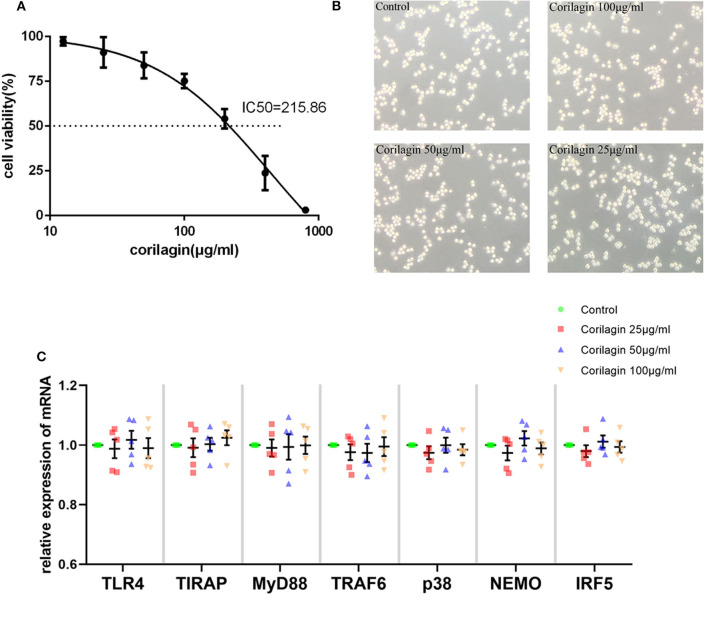
Cytotoxicity of Corilagin (A) CCK8 assay of Ana-1 cell viability. The concentration–effect curve was Y = (152.95/(1+10logX−2.635)−51.95. IC50 = 215.86 μg/ml. (B) Morphology of Ana-1 cells after corilagin treatment for 24 h. (C) mRNA expression measured by qRT-PCR. Data are the mean and SEM. No significant difference was found between groups determined by one-way ANOVA and subsequent S–N–K method (n = 5).